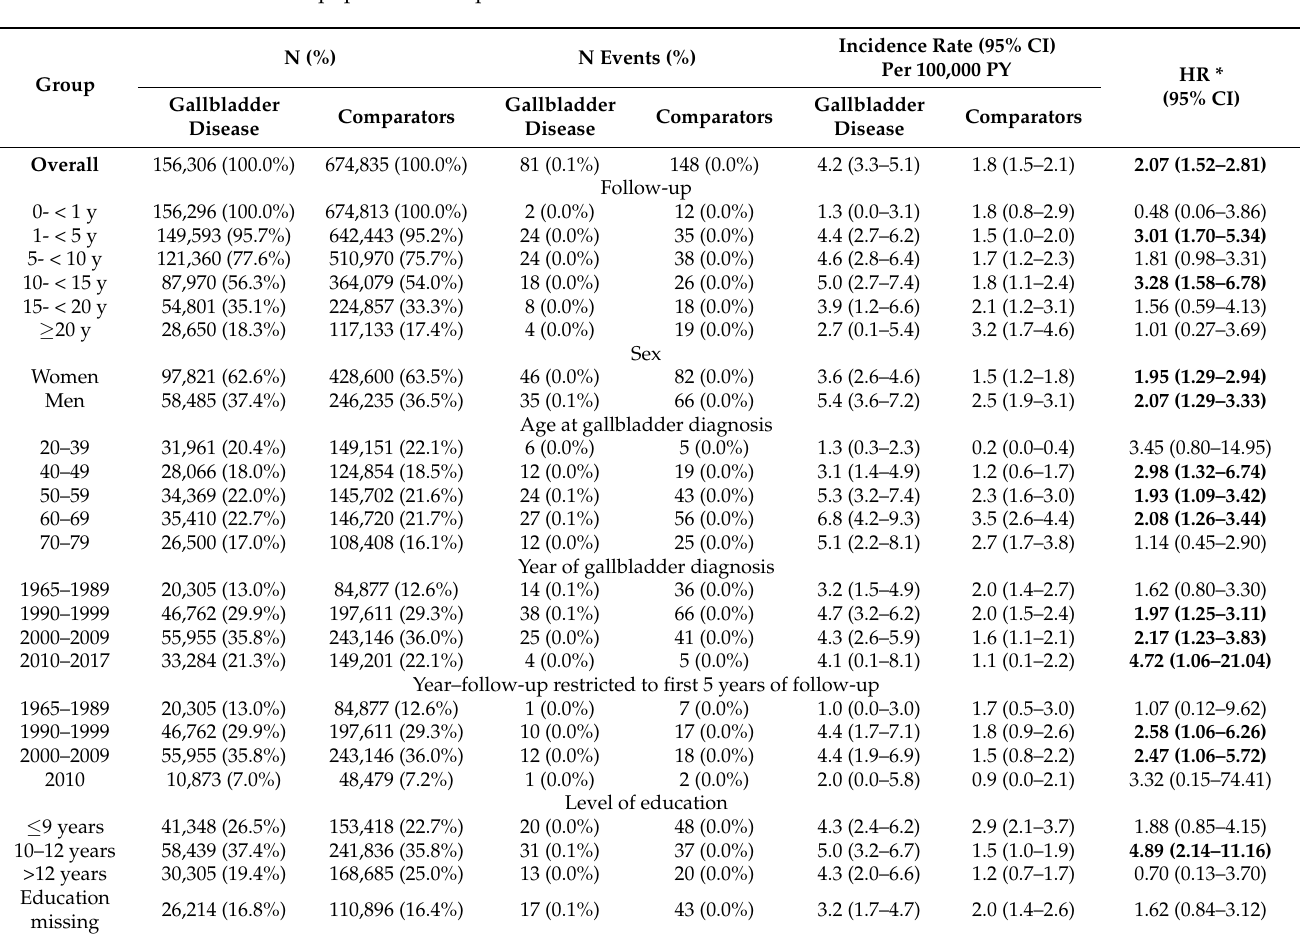
Table 4. Stratified risk of carcinoids in individuals with gallbladder disease and matched general population